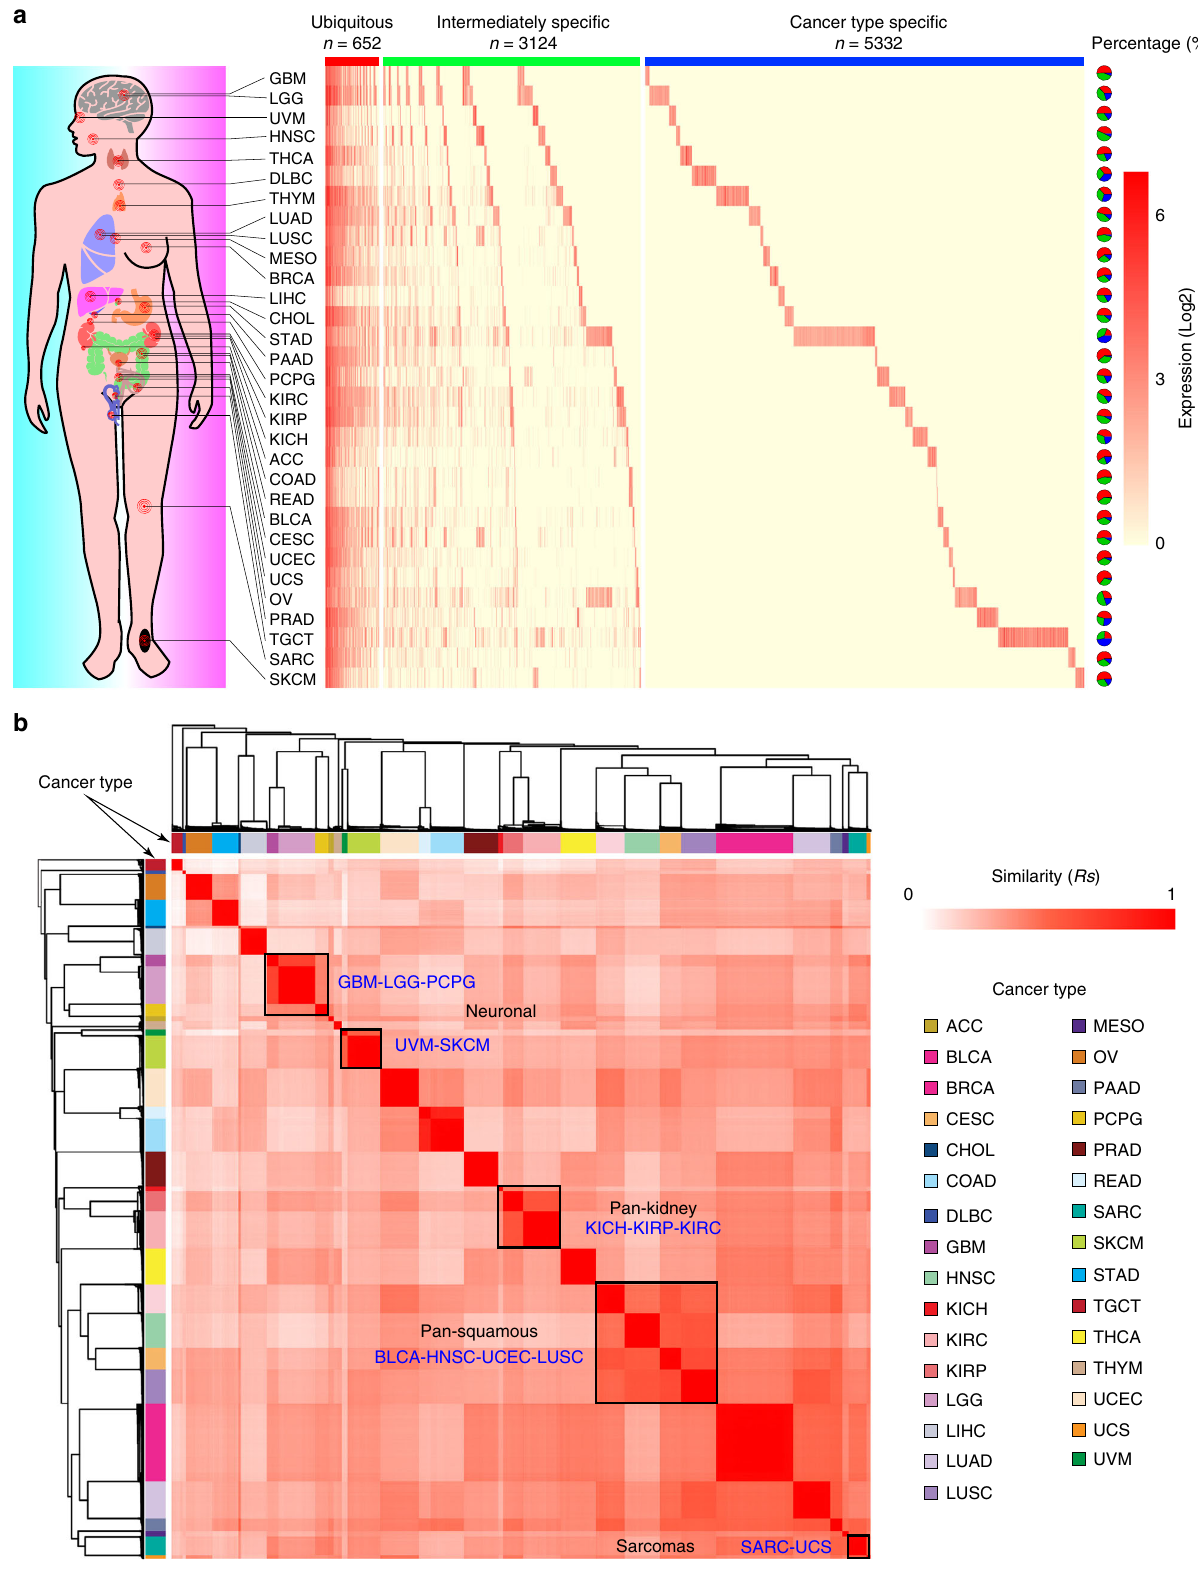
Fig. 1 Expression landscape of eRNAs in human cancers. a Expression pro fi le of eRNA in human cancers. Red, green and blue bars, respectively, denote ubiquitous, intermediately speci fi c and cancer-type-speci fi c eRNAs. Pie charts re fl ect the percentage of each category of eRNAs in each cancer type. Abbreviation of each cancer type is listed in Supplementary Data 1. Scale bar denotes the expression level of eRNAs (log2). Organ icons made by Freepik (https://www.freepik.com/). b Expression similarity among tumor samples. Color bar denotes each cancer type. Scale bar denotes the similarity of eRNA expression among TCGA